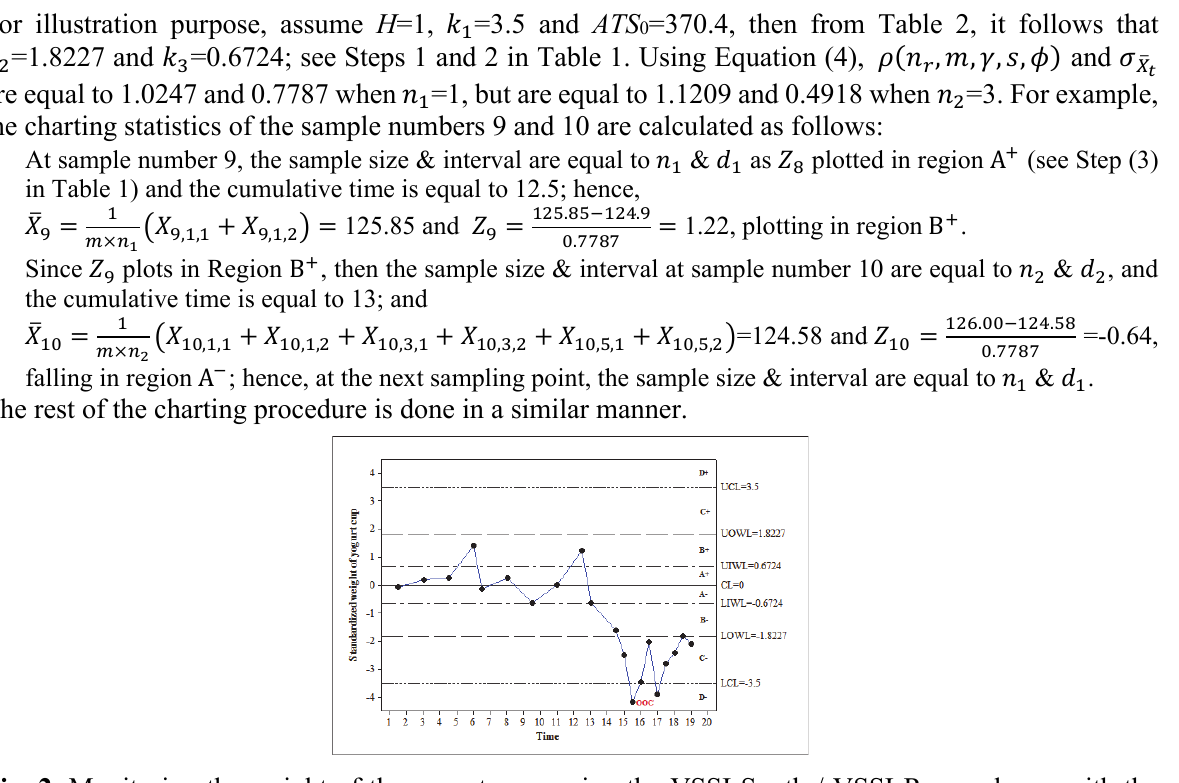
Fig. 2. Monitoring the weight of the yogurt cups using the VSSI-Synth / VSSI-Runs scheme with the 1&2 sampling